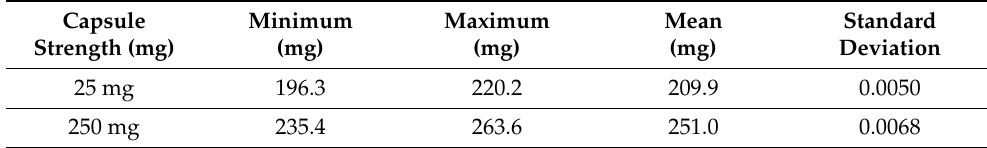
Table 2. Weight variation of 25 mg and 250 mg CA capsules (n =